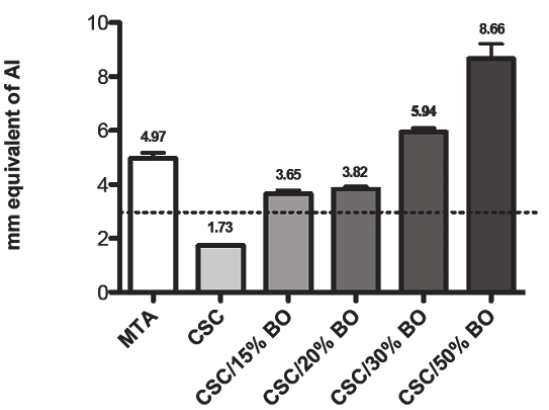
Figure 1 - Mean and standard deviation of radiopacity val- ues in millimeters of aluminum